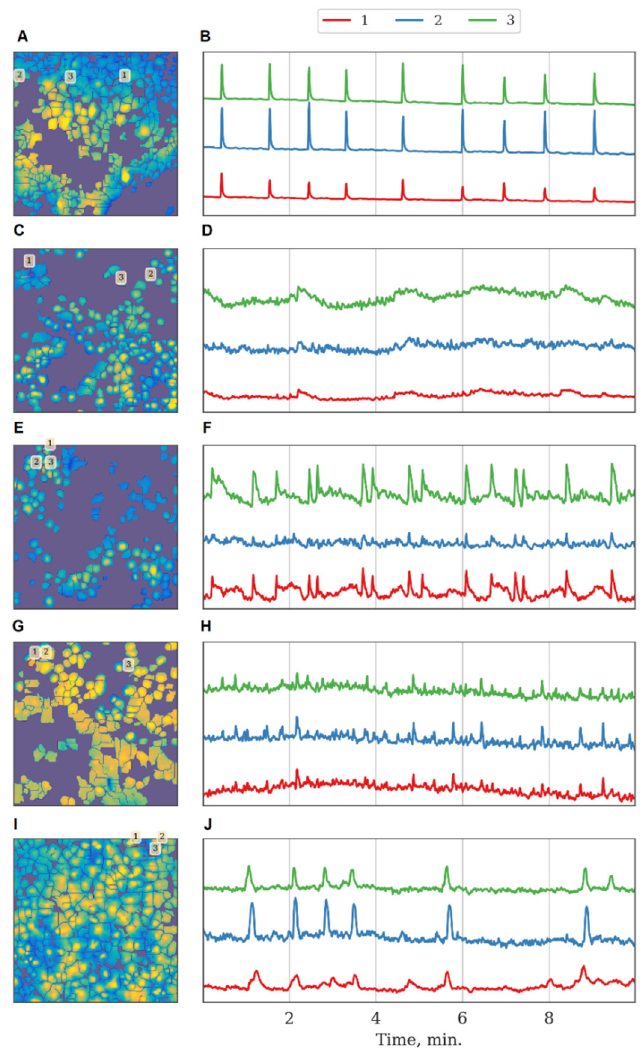
Figure 4. Characteristic examples of the dynamics of Oregon Green calcium sensor fluorescence in primary monoastrocytic cultures in vitro. ( A , B ) Sham, ( C , D ) eEF2k, ( E , F ) Ikkb, ( G , H ) FLT4, ( I , J ) SRC kinase.